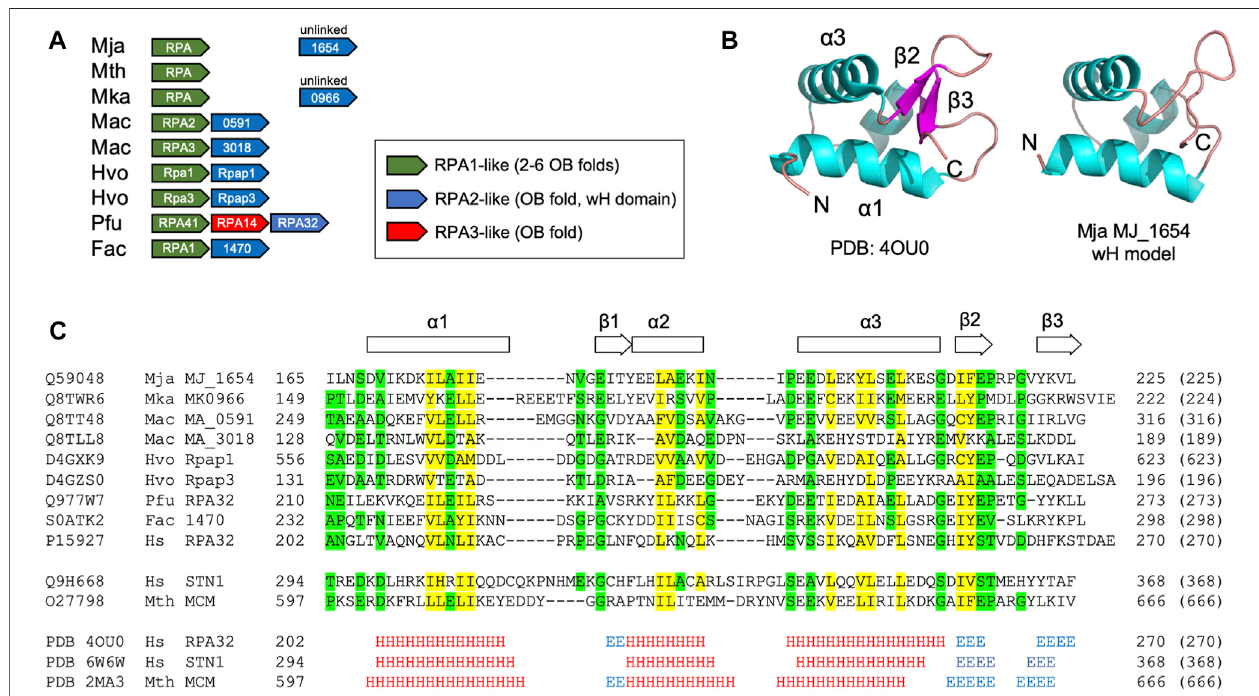
FIGURE 3 | Winged helix-turn-helix (wH) domain in the archaeal RPA2-like proteins (A) Chromosomalorganisation of ORFs encoding biochemically characterised archaealRPA1-likeandRPA2-likeproteins(showningreenandblue,respectively).Linked(adjacent)andunlinkedORFsareshown (B) Right:CrystalstructureofthewH domain at the C-terminus of the human RPA32 protein (PDB: 4OU0, RPA32 is the human orthologue of yeast RPA2). The structure comprises a three-helix bundle ( α 1 – α 3) capped by a ß -hairpin ( β 1 – β 3) (Feldkamp et al., 2014). Left: Structural model of the C-terminal wH domain (amino acids 169 – 225) of the M. jannaschii RPA2-like protein MJ_1654 based on its similarity to human RPA32 (amino acids 206 – 270, PDB: 4OU0). The model was generated using HHpred (Zimmermann et al., 2017) and MODELLER 10.1 (Webb and Sali, 2021) (C) Protein sequence alignment (as Figure 1 , but with colouring applied when similar amino acids are present in seven of nine RPA2-like RPA proteins shown) of the putative wH domains of archaeal and eukaryotic RPA proteins, along with the human RPA2-like protein STN1 (Lim etal.,2020)andthe M.thermautotrophicus MCMwHdomains(Wiedemannetal.,2015).Alignmentsre fl ecttheoutputofHHpredsearches( Table1 )exceptfortheMac MA_318 and Hvo Rpap3 proteins which were manually aligned. The full ID of the Ferroplasma acidarmanus ORF/protein labelled 1470 is FACI_IFERC00001G1470. Abbreviations:Mja, M.jannaschii ;Mth, Methanothermobacterthermautotrophicus ;Mka, Methanopyruskandleri ;Mac, M.acetivorans ;Hvo, H.volcanii ;Pfu, Pyrococcus furiosus ; Fac, Ferroplasma acidarmanus ; Hs, human; Sc, Saccharomyces cerevisiae ; and Um, Ustilago maydis